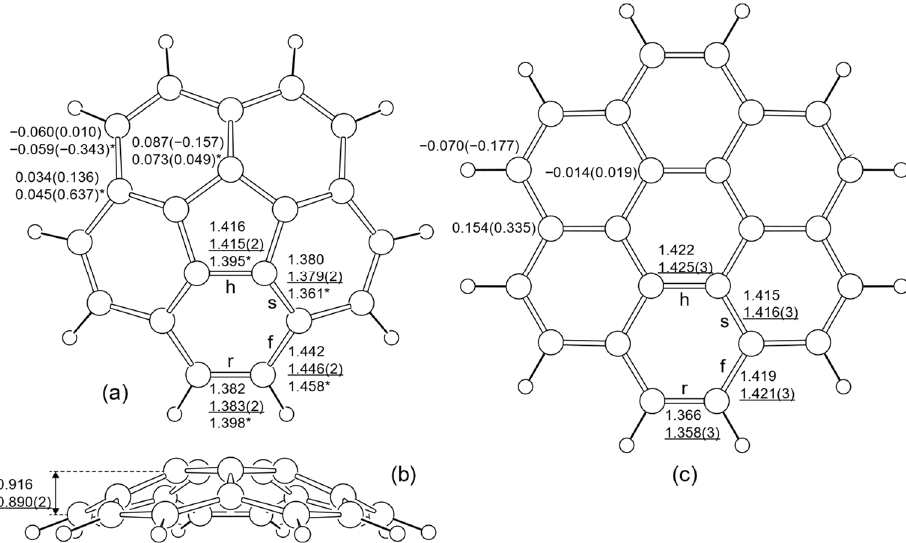
Figure 2. ( a,b ) C 5v geometry of corannulene and ( c ) D 6h geometry of coronene, optimised at the B3LYP-D3(BJ)/def2-TZVP level, with bond lengths and bowl depth (in Å) and Mulliken charges. Top bond lengths from the optimised geometries, underlined bond lengths with estimated standard deviations from X-ray data, bond lengths and Mulliken charges marked with asterisks from the D 5h optimised geometry of corannulene (not shown separately). B3LYP/def2-TZVP and B3LYP/6- 311++G(d,p) Mulliken charges (in brackets). Mulliken charges for hydrogens summed into those for rim carbons. For further details, see text.